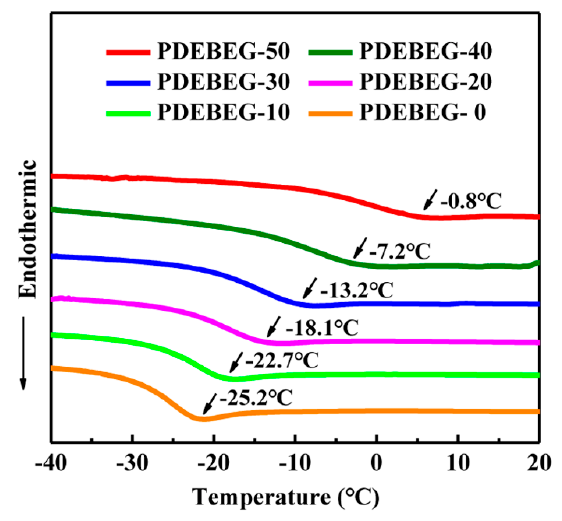
ff erent diethyl itaconate Figure 5. DSC thermograms of PDEBEG with different diethyl itaconate contents. Figure 5. DSC thermograms of PDEBEG with different diethyl itaconate contents. Figure 5. DSC thermograms of PDEBEG with di